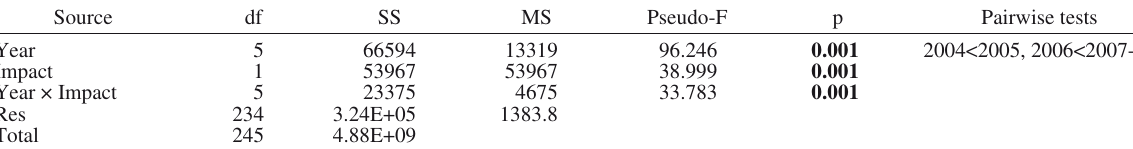
Table 2. – Results of PERMANOVA testing for differences in fish assemblage structure during study years (“Year” fixed factor) and between locations (“Impact”, fixed factor). Significant differences (p<0.01) are highlighted in bold. Results of pairwise comparisons between locations for each year are included as a result of a significant interaction between Year and Impact.